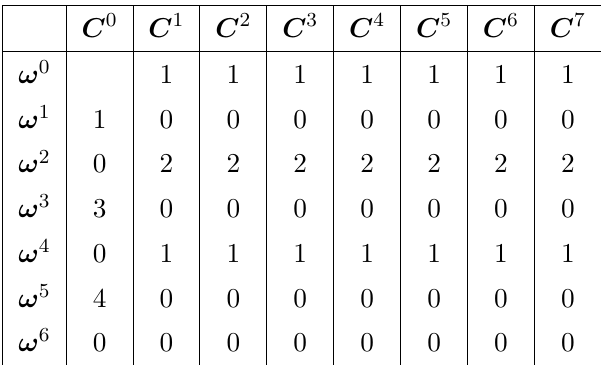
Table 1 . Observables in 4 d HSGRA to the lowest order (both in the physical and unphysical sectors). The number in each cell is the number of independent observables that are of ω m C n -type. The table extends trivially in both directions; here, we kept a part that shows some irregularity